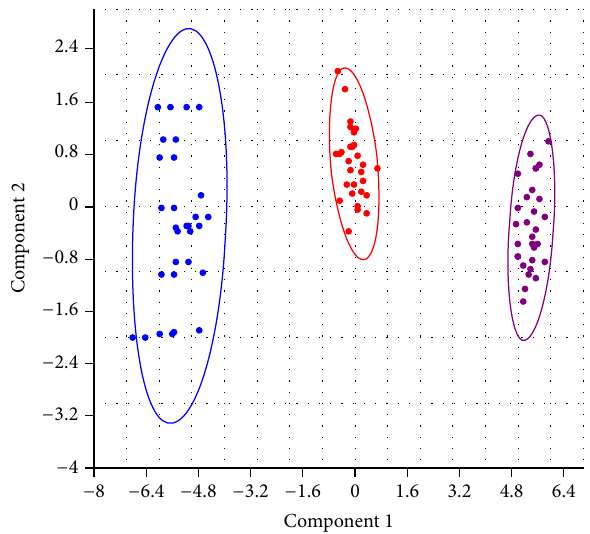
Figure 2: Scatter plot of PC 1 on PC 2 showing 95% confidence ellipses of three subpopulations of C. punctatus . Red, violet, and blue colours indicate Gomti River, pond of Malihabad, and pond of Kolkata subpopulation, respectively.